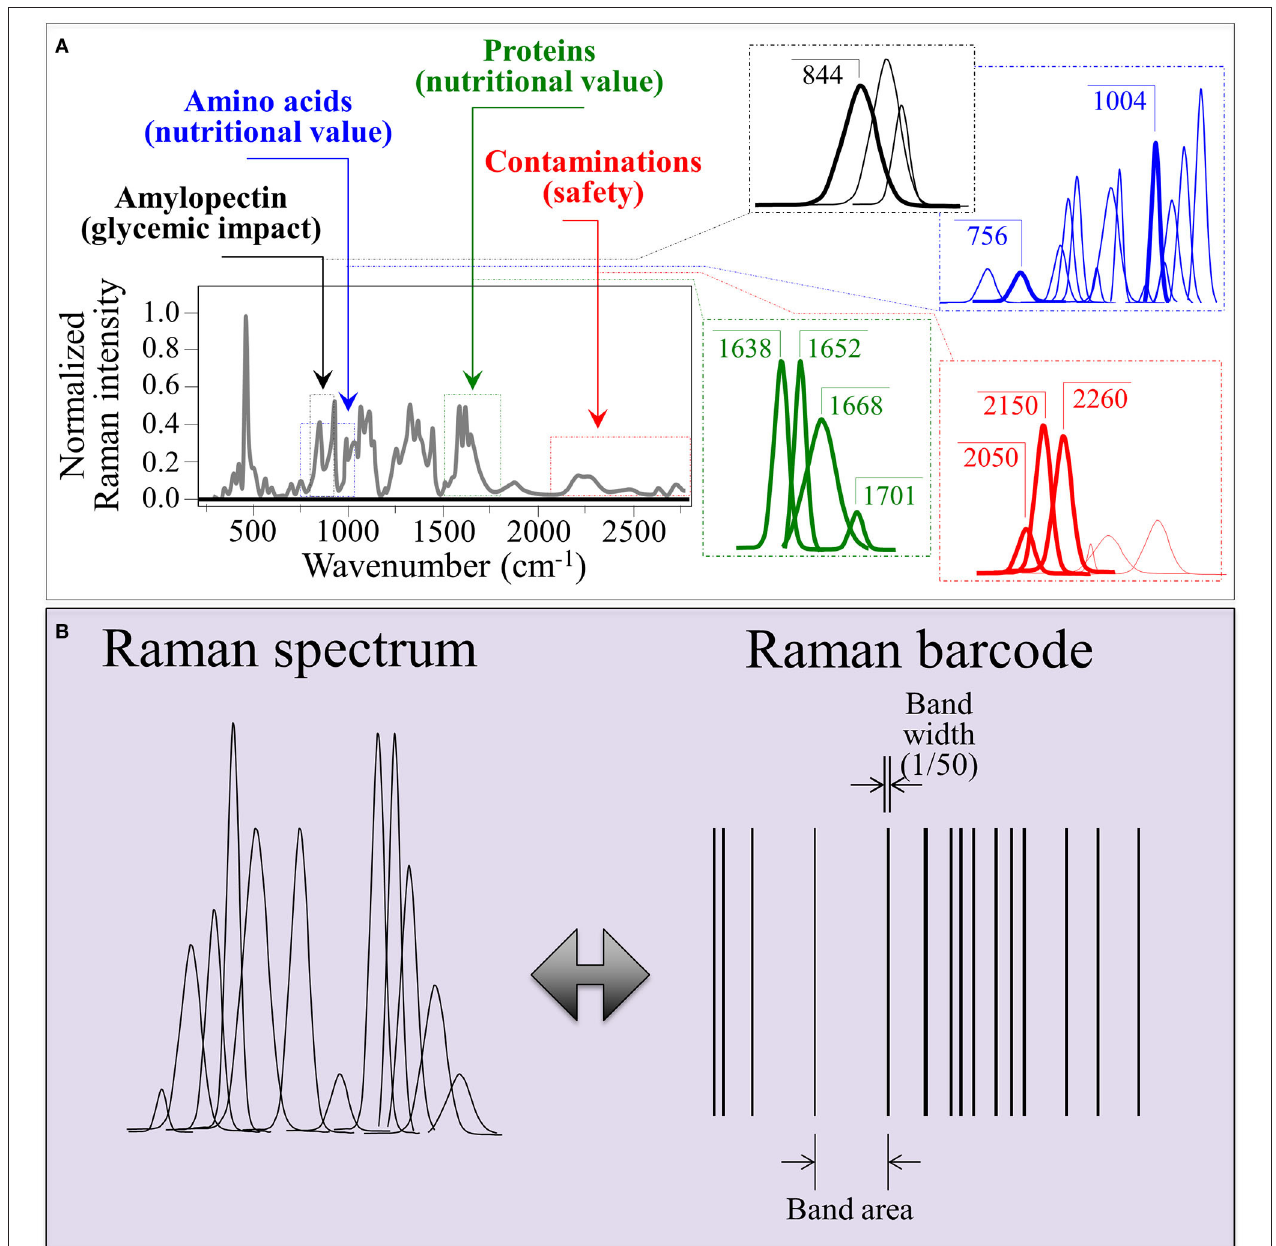
FIGURE 9 | (A) Schematic drafts locating different zones of the Raman spectrum representing different nutritional and quality characteristics and their deconvoluted sub-band components; and (B) , a proposed algorithm to convert the sub-band sequence into a linear barcode.